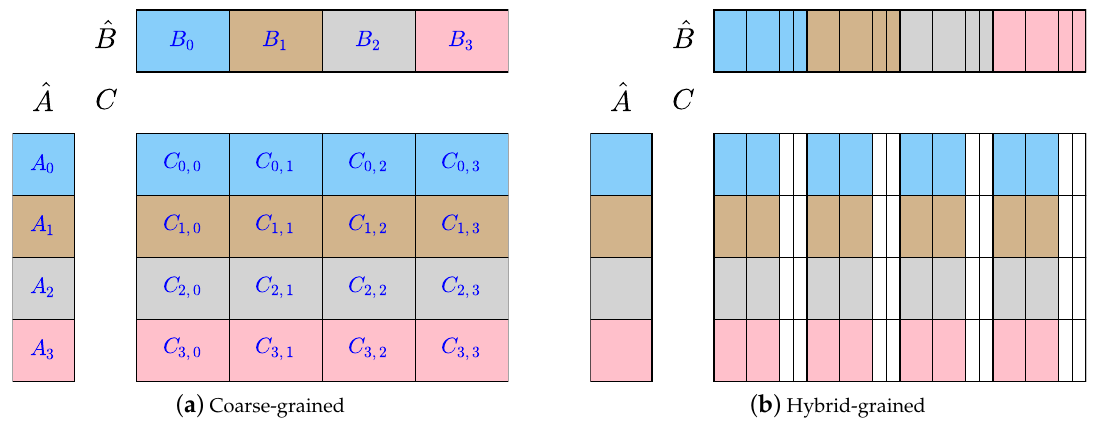
Figure 2. GEMM parallelization. ( a ) Coarse-grained. ( b )